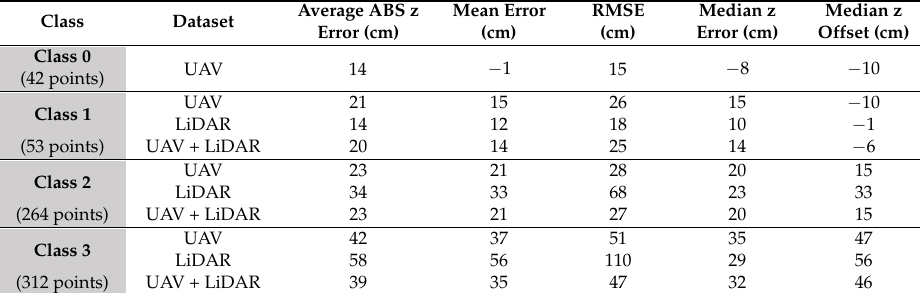
Table 2. Dataset Accuracies: Comparison of Dataset Elevations against RTK Point Elevations Classified by Surface